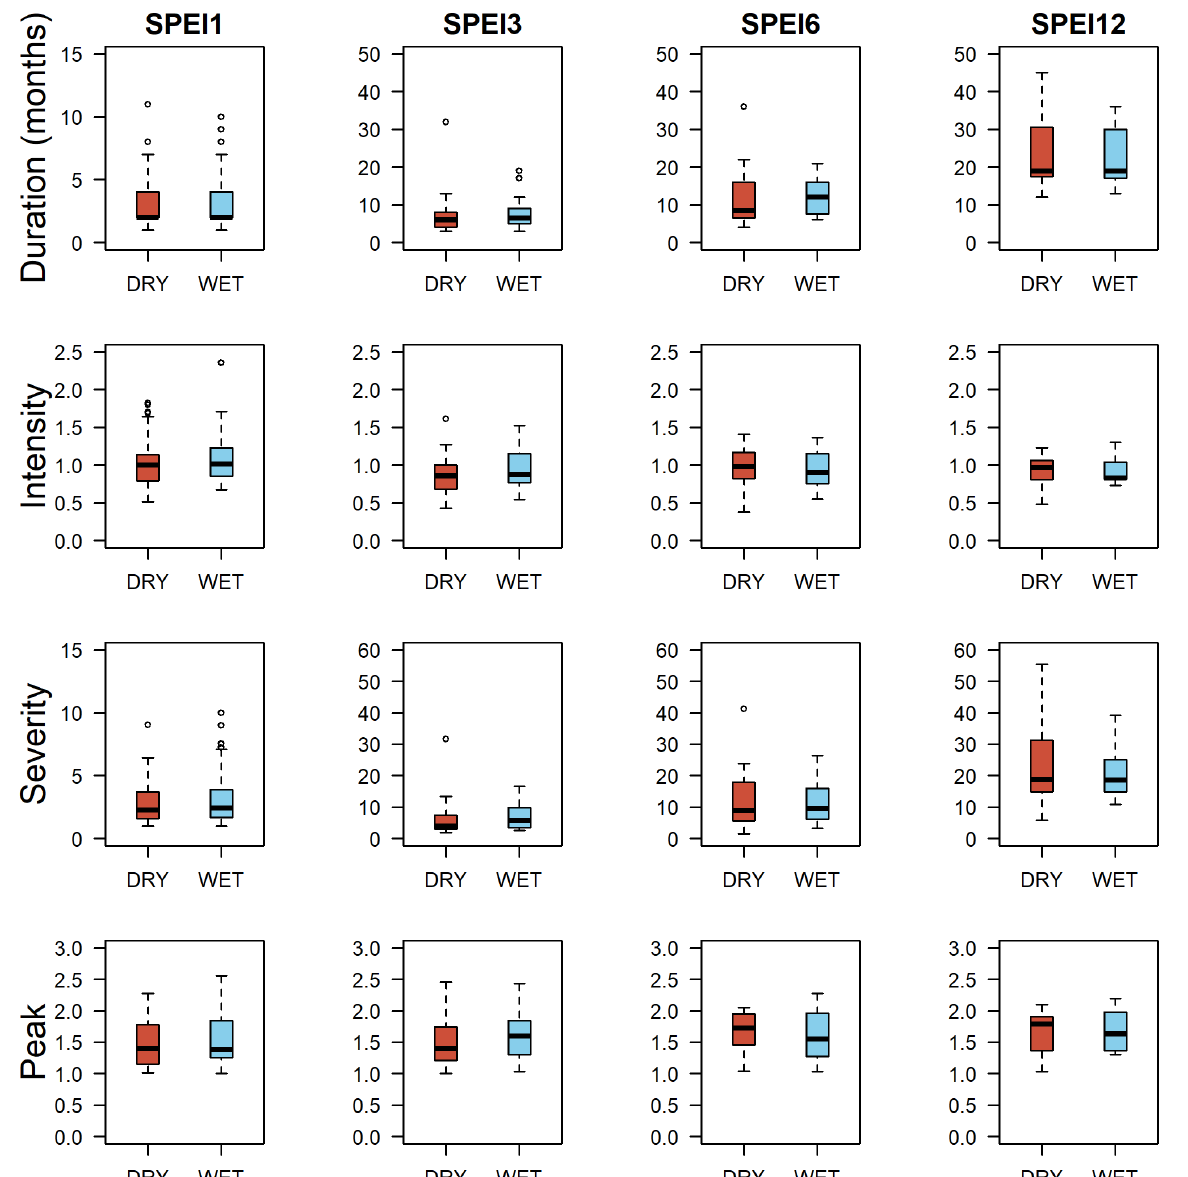
Figure 5. Boxplot diagrams for the four parameters (duration, intensity, severity, peak; lines) characterizing the climate dry (reddish boxes) and wet (bluish boxes) events identified at domain-scale over ESA during 1980 – 2018 at SPEI-1, SPEI-3, SPEI-6, and SPEI-12 (columns). Boxes delineate the median, upper, and lower quartiles, with the whiskers representing the lowest and highest value for the parameters associated with the events. Tables 2 and 3 list the dry and wet events, respectively. Data are from CRU TS 4.03.